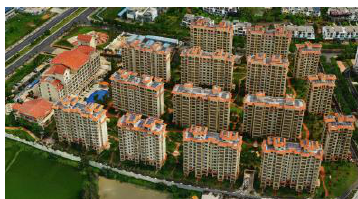
Fig 12. 3D visualisation of urban reality 3D model